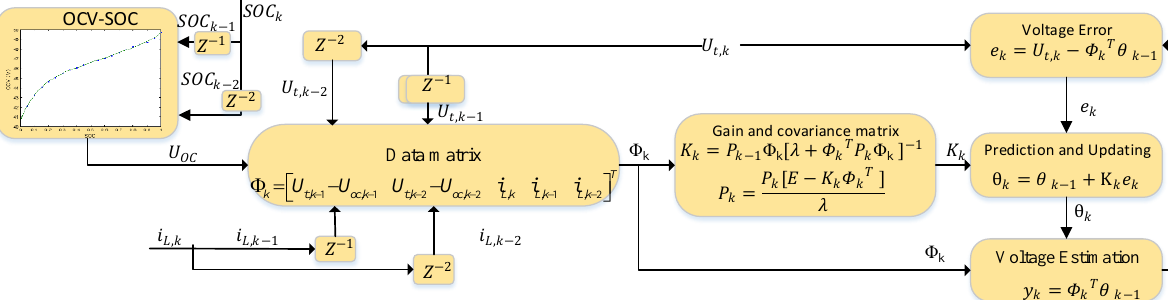
Figure 2. Battery parameter identification based on the forgetting-factor recursive-least-squares (FFRLS) method. OCV: open circuit voltage; SOC: state of charge.